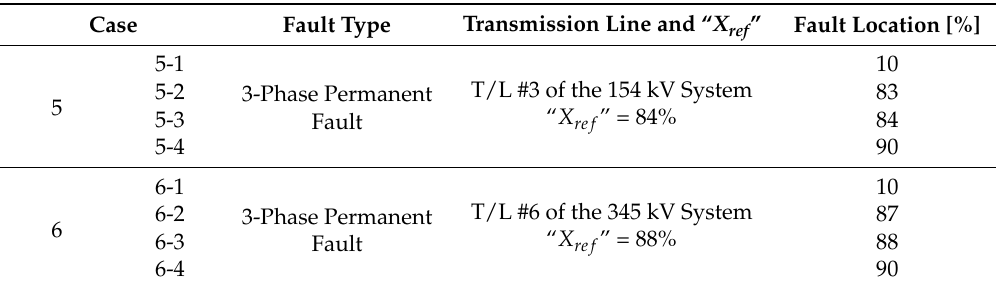
Table 5. Simulation cases for verification of the